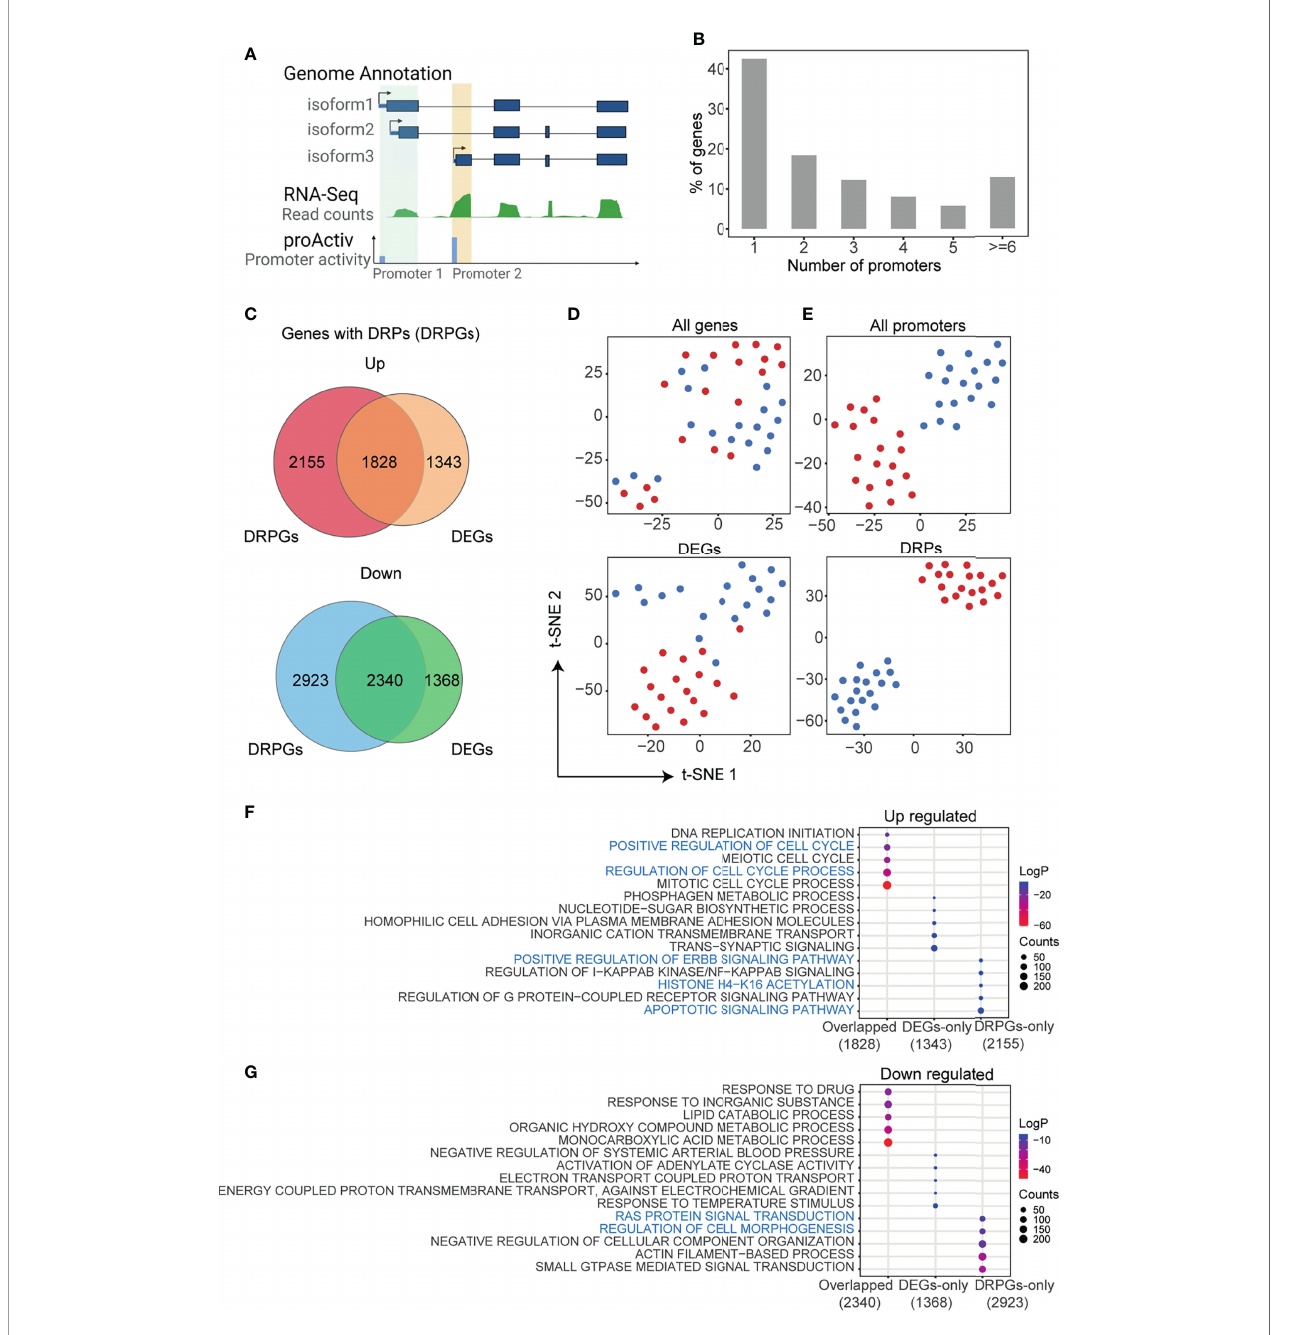
FIGURE 1 | Analysis of promoter activities in HCC. (A) Schematic representation of promoter activities of different transcript isoforms. Transcripts with the same or nearby transcript start site are grouped into the identical promoter. Promoter activity is de fi ned as the total unique junction reads spanning at each promoter (see also Materials and Methods ). The green track represents gene expression of tissue normalized by reads counts, blue track represents the activity of each promoter. (B) The number of promoters with activities in HCC per gene, a total of 25,085 genes with 70,736 promoters included. (C) Venn diagrams showing the overlap of differentially expressed genes (DEGs) and genes with differentially regulated promoters (DRPGs) for upregulated (top) and downregulated (bottom) ones. (D, E) t- distributed stochastic neighbor embedding (t-SNE) clustering the sequenced samples by FPKM for all genes or DEGs (D) and by promoter activities for all promoters or DRPs (E) . Samples were colored by sample types (dark red: HCC; dark blue: adjacent normal tissue). (F, G) Bubble plots showing the enriched biological processes by gene ontology (GO) analysis of gene groups in (C) . The bubble color represents the log 2 ( p -value) while the bubble size represents enriched gene